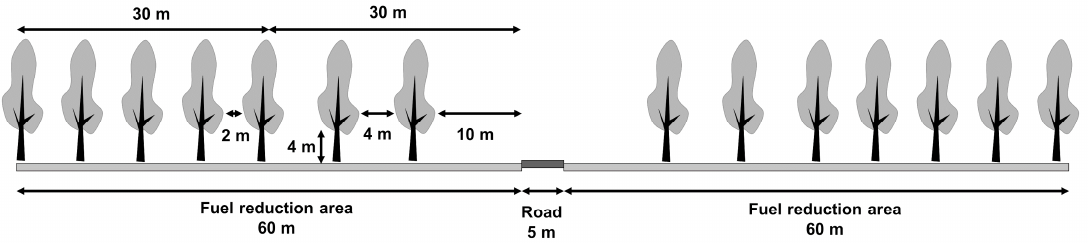
Figure 1. Transversal view of a model fuel break. The total width is 125 m. The distance between tree crowns decreases with the distance to the road. The first 10 m on the sides of the road have no vegetation. Adapted from [10].